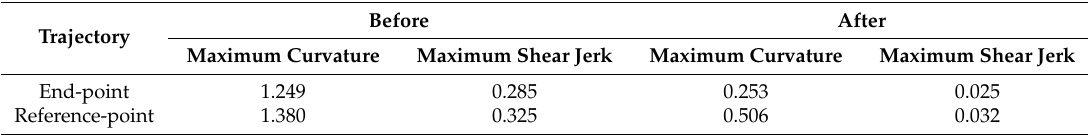
Figure 3. The initial fitted polishing trajectory for fairing optimisation and interpolation ( a ) the fitted polishing trajectory ( b ) the partial enlarged view. Table 1. Changes in the two trajectories before, and after, fairing optimisation.